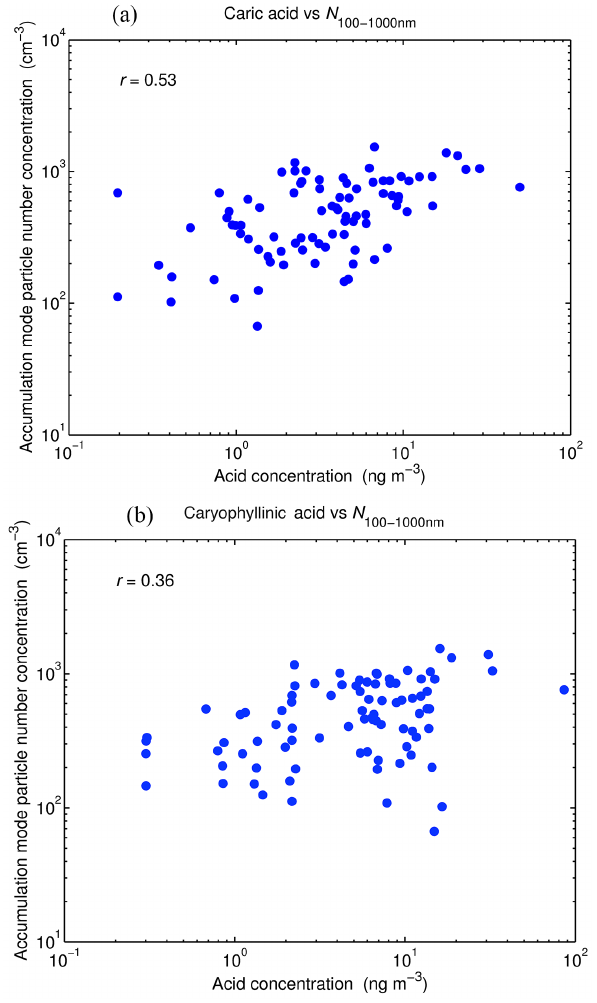
Figure 4. Correlations between caric acid (a) and β -caryophyllinic acid (b) and the accumulation-mode particle number concentra-